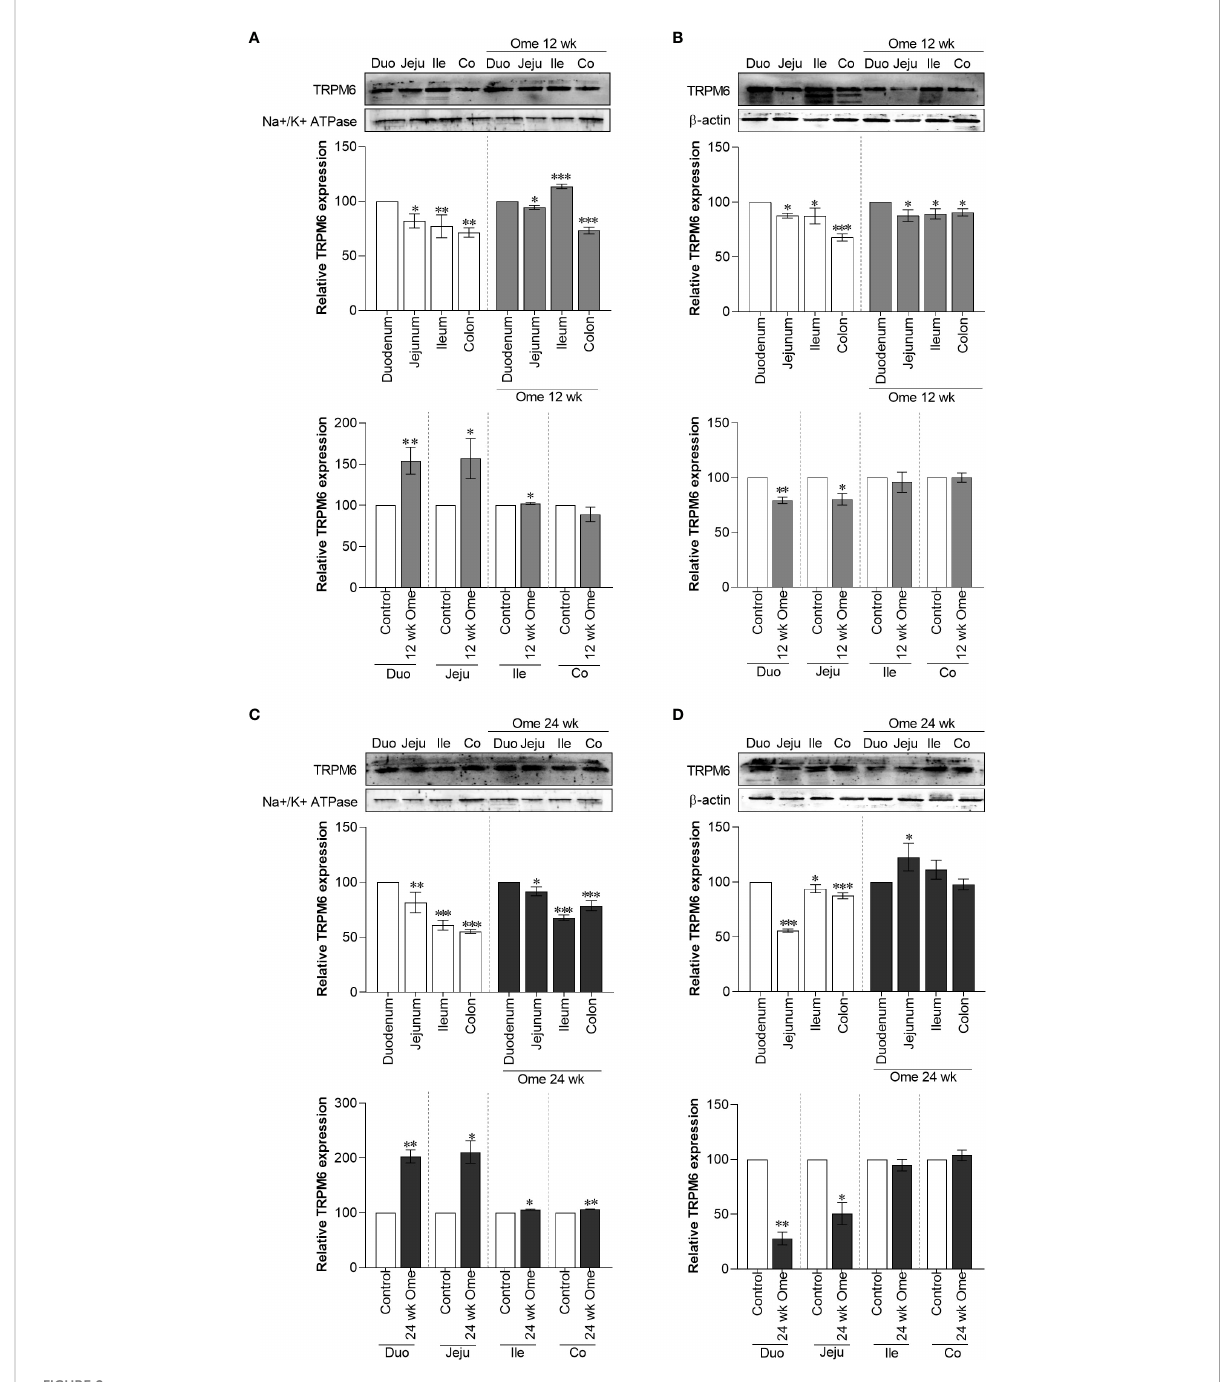
FIGURE 2 Membrane TRPM6 (A) and cytosolic TRPM6 (B) expression in duodenum, jejunum, ileum, and colon of control or 12 wk omeprazole-treated rats. Membrane TRPM6 (C) and cytosolic TRPM6 (D) expression in duodenum, jejunum, ileum, and colon of control or 24 wk omeprazole- treated rats. The upper relative expression graph; the protein expression in jejunum, ileum, and colon was relatively compared to that of in the duodenum. The lower relative expression graph; the protein expression in duodenum, jejunum, ileum, and colon of omeprazole-treated groups was relatively compared its corresponding segment of control group. Duo, duodenum; Jeju, jejunum; Ile, ileum; Co, colon; ome, omeprazole. * P < 0.05, ** P < 0.01, *** P < 0.001. ( n =